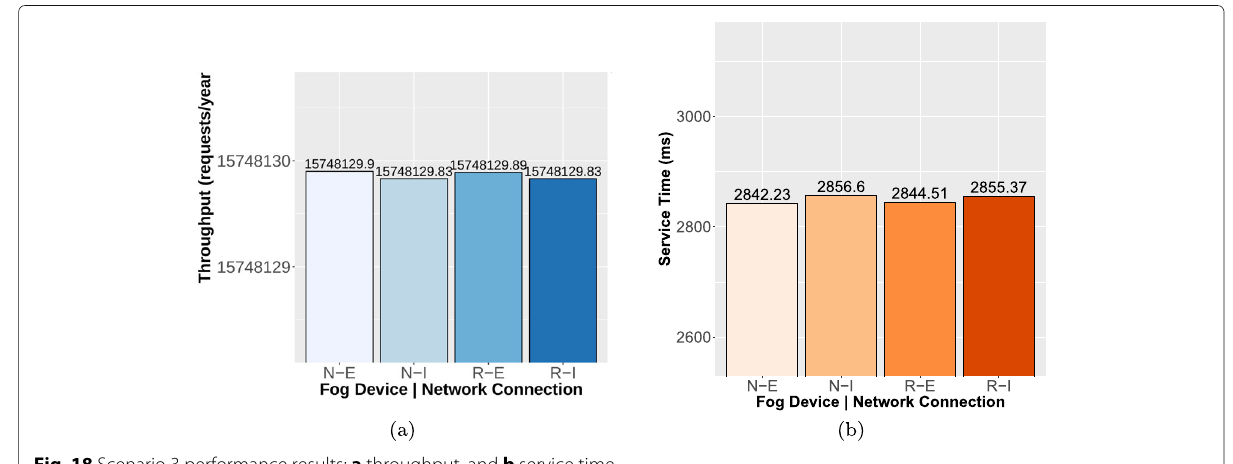
Fig. 18 Scenario 3 performance results: a throughput, and b service time